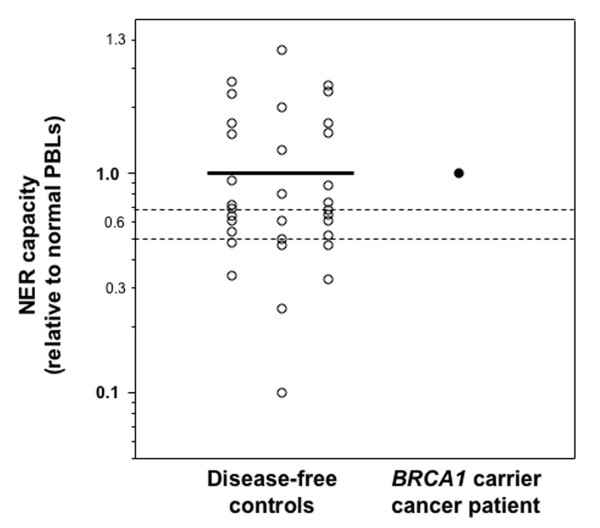
Comparison of the NER capacity of a PBL sample from our BRCA1 mutation carrier patient with those of a population of disease-free controls. The dark horizontal line indicates the average for the normal population, while the dotted lines indicate upper limits for residual NER activity in patients with the hereditary NER deficiency disease XP (0.50) and the cut-off established in our breast tissue study that identified tumors with high sensitivity and specificity (0.70).